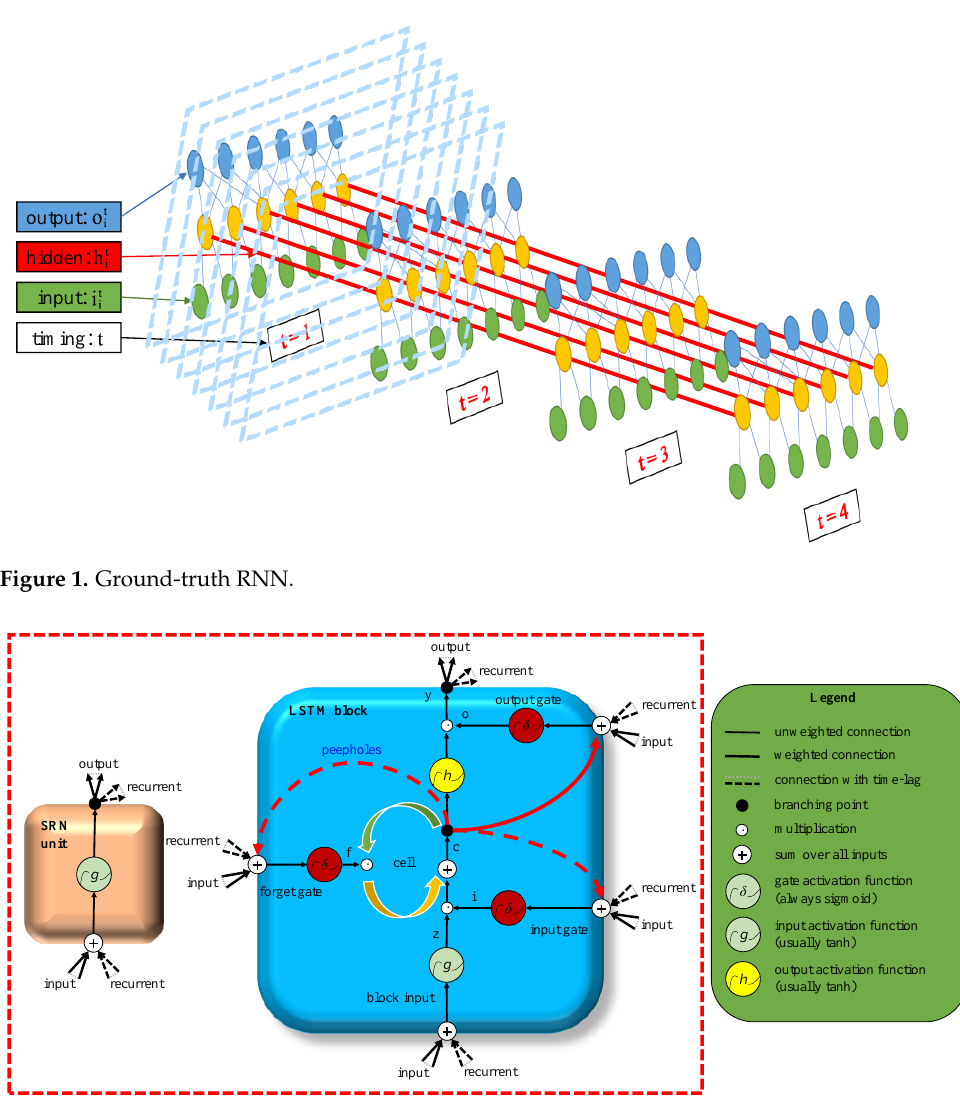
Figure 2. SRN and LSTM modules.